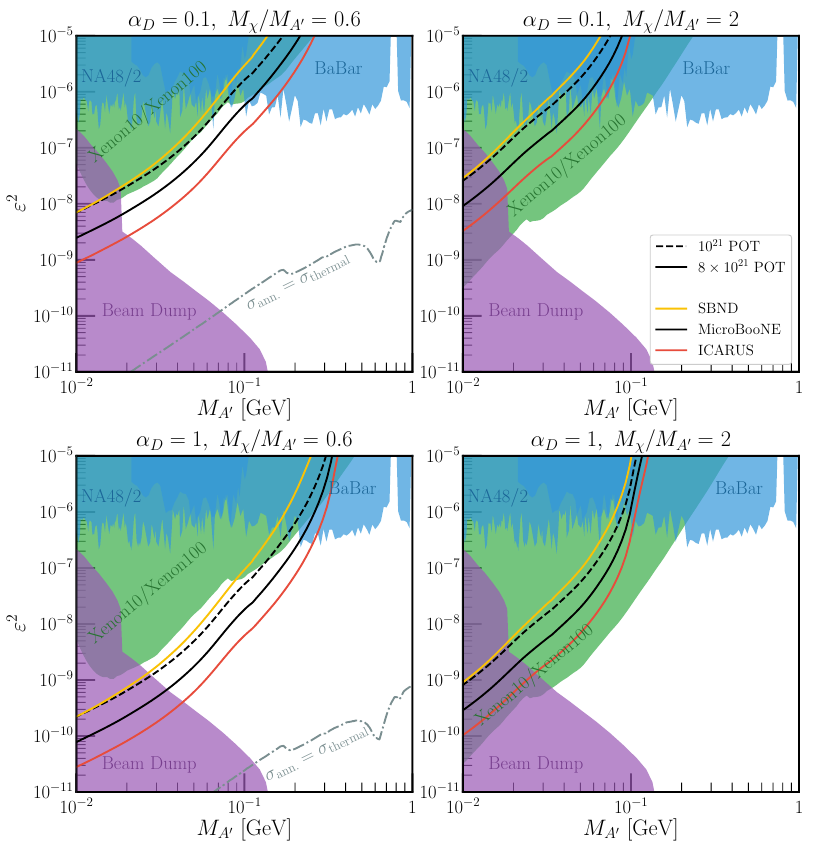
Figure 3 . Similar to (cid:12)gure 2 but for the case of asymmetric dark matter. In order to e(cid:14)ciently deplete the symmetric relic density, the annihilation cross section needs to be above the thermal one. For the left panels, this corresponds to values of " larger than those of the thermal (blue, dot-dashed) curves. The xenon direct detection experiments excluded the green-colored regions. (cid:31) + (cid:22) (cid:31) -annihilations during the formation of the cosmic microwave background (CMB)